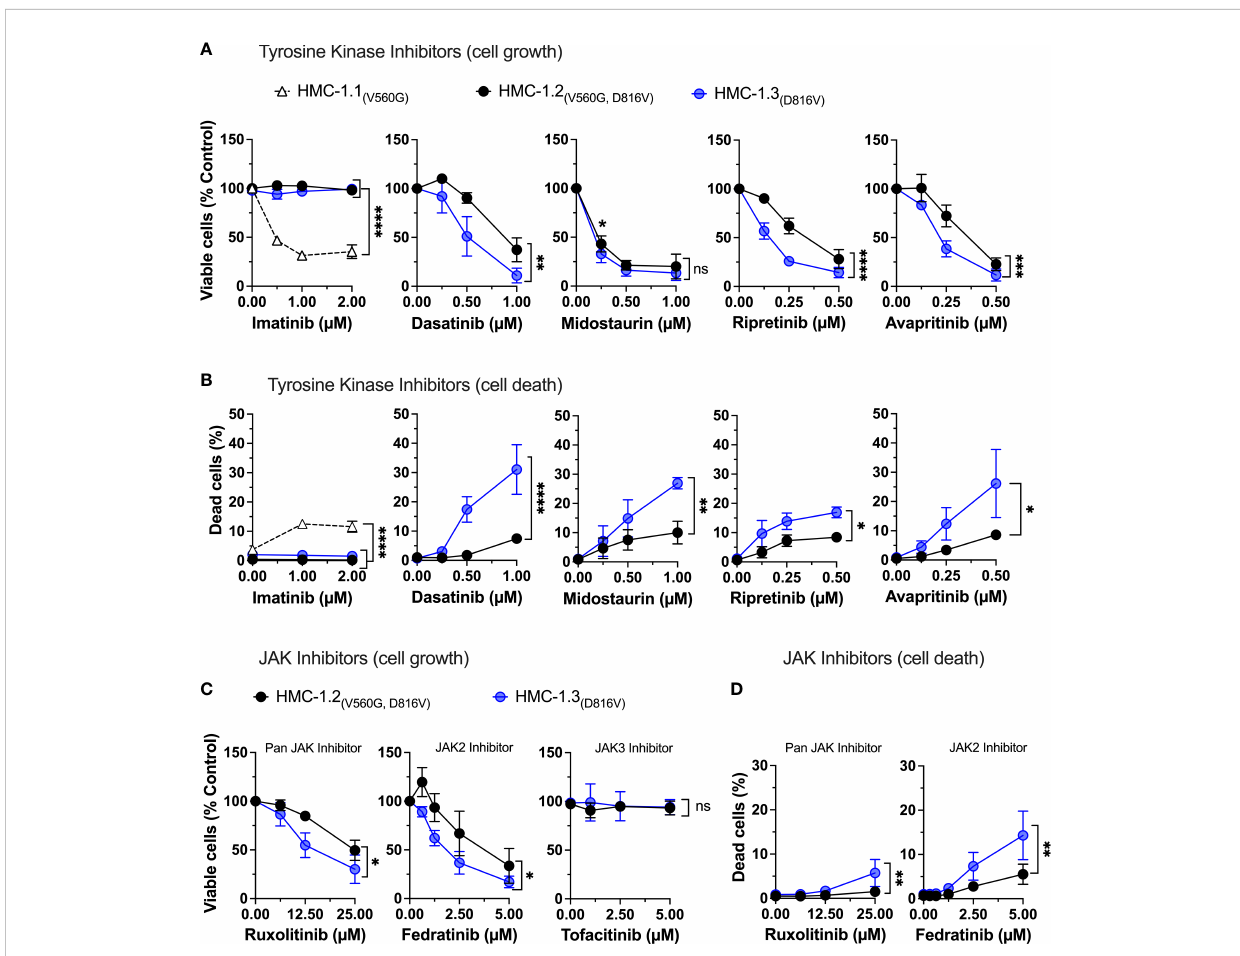
FIGURE 5 Repair of the G560V-KIT mutation in HMC-1.2 results in higher sensitivity to common tyrosine kinase inhibitors and JAK2 inhibitors. Effects of the indicated tyrosine kinase inhibitors on cell growth (A) and cell death (B) in HMC-1.2 and HMC-1.3 cells. Graph represents the percentage of viable or dead cells after 72 h in the presence of the indicated concentrations of inhibitors compared to the corresponding cells treated with vehicle (0 µM). Effects of the JAK inhibitors on cell growth (C) and cell death (D) in HMC-1.2 and HMC-1.3 cells. Graph represents the percentage of viable or dead cells after 72 h in the presence of the indicated concentrations of inhibitors compared to cells treated with vehicle (0 µM). Total cells were counted using a Celigo Image Cytometer and viable cells calculated after subtraction of dead cells which were positive for PI staining. In (A-D) , data represent Mean ± SD of 3 independent experiments. ns not signi fi cant; *p<0.05; **p<0.01; ***p<0.001; ****p<0.0001 using two-way ANOVA are indicated as brackets between the curves. Note that there were no differences between the curves of inhibition by midostaurin, but at 0.25 µM the percentage inhibition was signi fi cantly greater in HMC-1.3 (* p<0.05) using multiple comparison 2-way ANOVA). Data on HMC-1.3 are the average of both 1H9 and 2E2